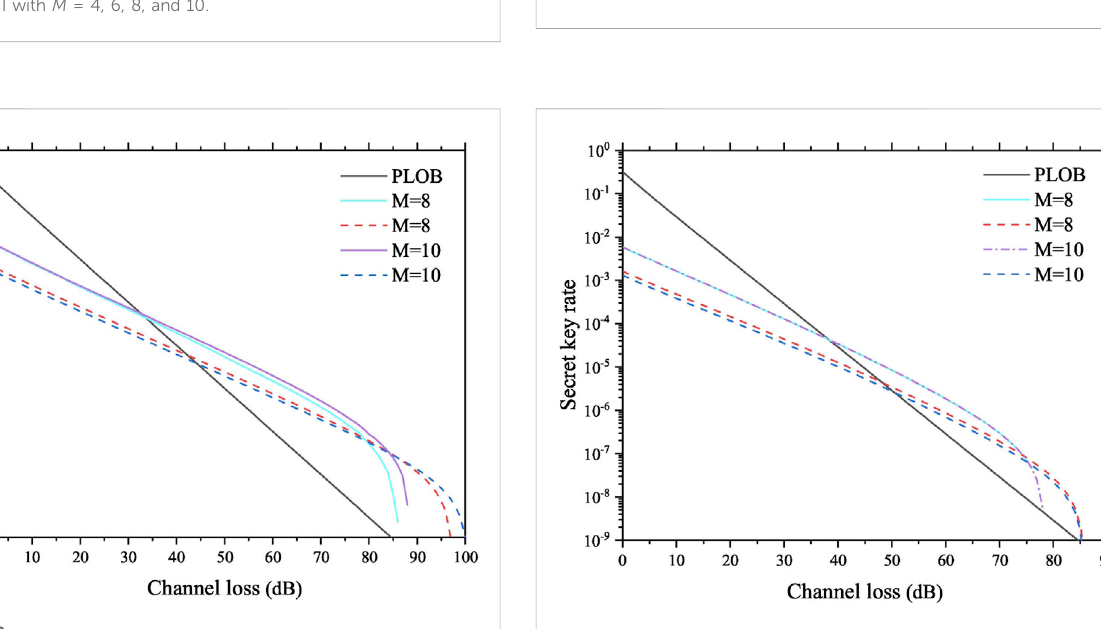
FIGURE 4 Comparison results of Protocol II and [35] with M = 8and 10.The solidcurveandthedot – dashcurverepresenttheresultsofProtocolII, and the dashed curves represent the results of